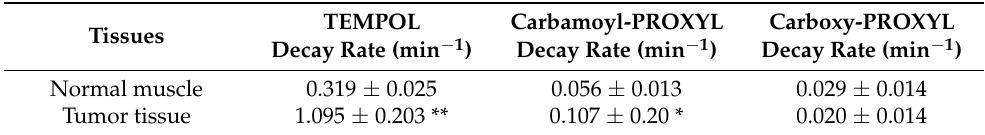
Figure 11. Comparison of pharmacokinetic profiles of three nitroxyl contrast agents by T 1 -weighted MRI. The pharmacokinetic profiles of oxidized form and total (nitroxyl radical form + hydroxylamine form) TEMPOL (left), carbamoyl-PROXYL (center), and carboxy-PROXYL (right). The time course of nitroxyl radical form in normal tissue (blue circle), tumor tissue (purple circle), blood (red circle), and kidney (left kidney, dark green circle; right kidney, light green circle) were obtained by T 1 -weighted MRI. The concentrations of total nitroxyl contrast agent (nitroxyl radical + hydroxylamine) measured by X-band EPR spectroscopy in the corresponding tissues are indicated by gray diamond or except black diamond for tumor tissue. The figure was partly modified from our previous report [103]. Table 1. Comparison of In Vivo Decay Rates of Nitroxyl-Induced T 1 -Weighted MRI Intensity in Normal and Tumor Tissues.